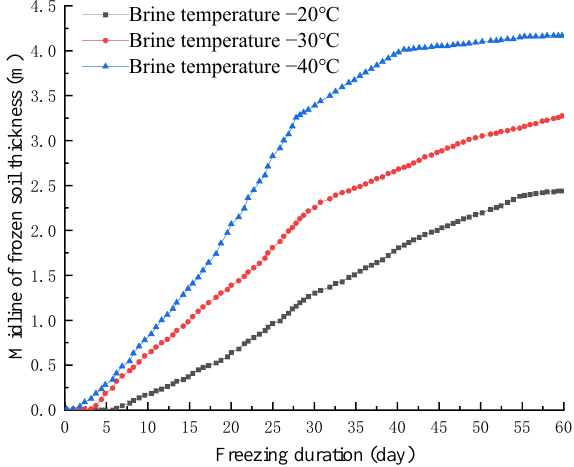
Figure 13. Thickness of frozen soil in the middle line between pipe jacking. Table 10. The freezing duration required in different brine temperatures (day). Midline of Frozen Soil Thickness